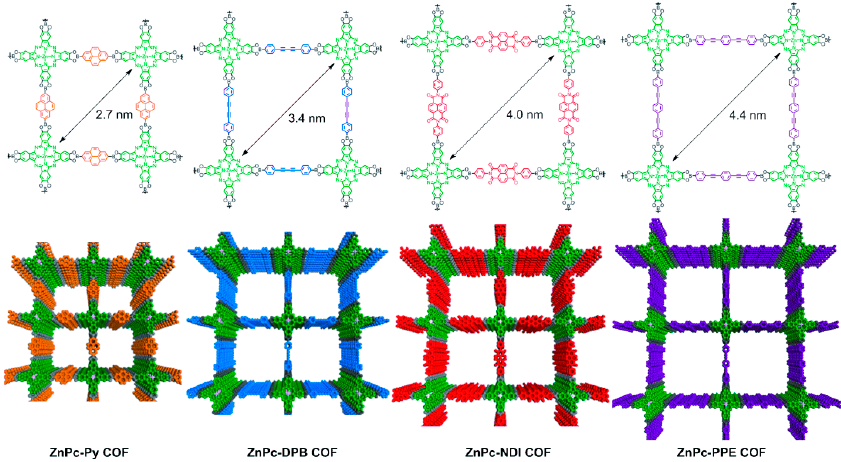
Figure 7. Relationships between the pore size of ZnPc COFs and different linkers, reproduced with permission from [149]. Copyright John Wiley and Sons, 2012.